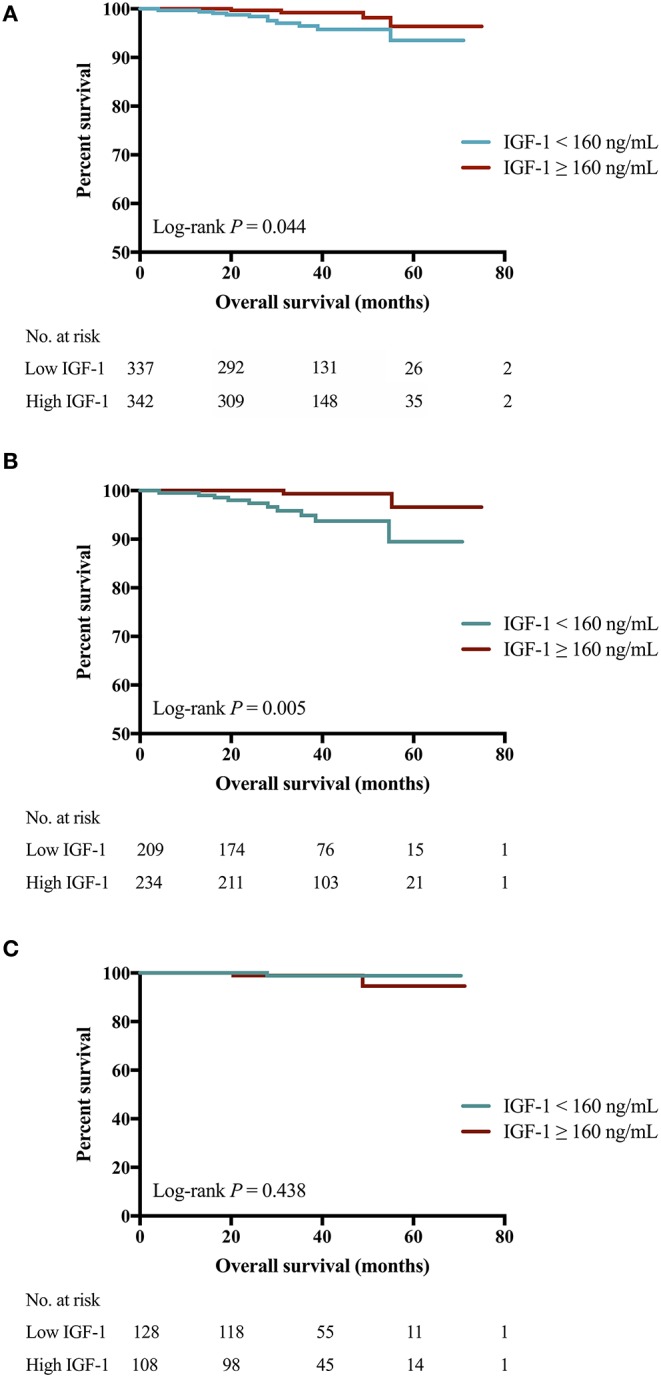
Impact of IGF-1 on OS among HER2-positive patients. (A) High IGF-1 group had superior OS than low IGF-1 group (4-years RFS 99.2 vs. 95.8%, Log-rank P = 0.044). (B) For patients of BMI <24.0 kg/m2, those with higher expression of IGF-1 had superior OS than those with lower IGF-1 (4-years OS 99.4 vs. 93.7%, Log-rank P = 0.005). (C) For patients of BMI ≥ 24.0 kg/m2, similar OS was found in those with lower or higher IGF-1 (4-years OS 98.9 vs. 98.7%, Log-rank P = 0.438). IGF-1, insulin-like growth factor-1; OS, overall survival; HER2, human epidermal growth factor receptor 2; BMI, body mass index; No, number.